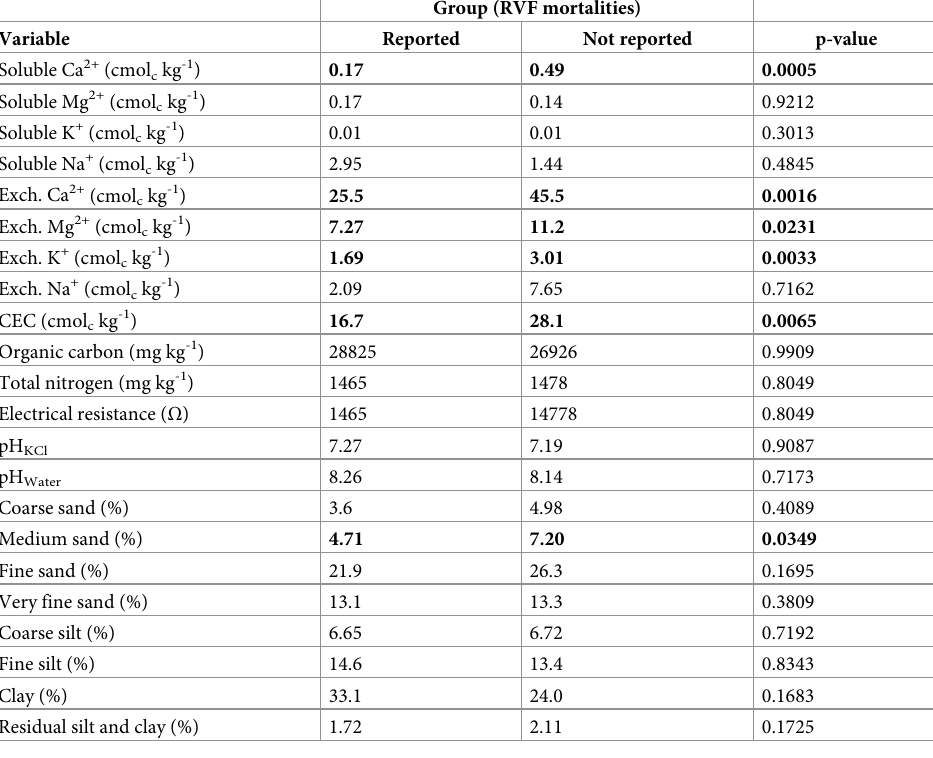
Values in bold-type differ significantly at p <